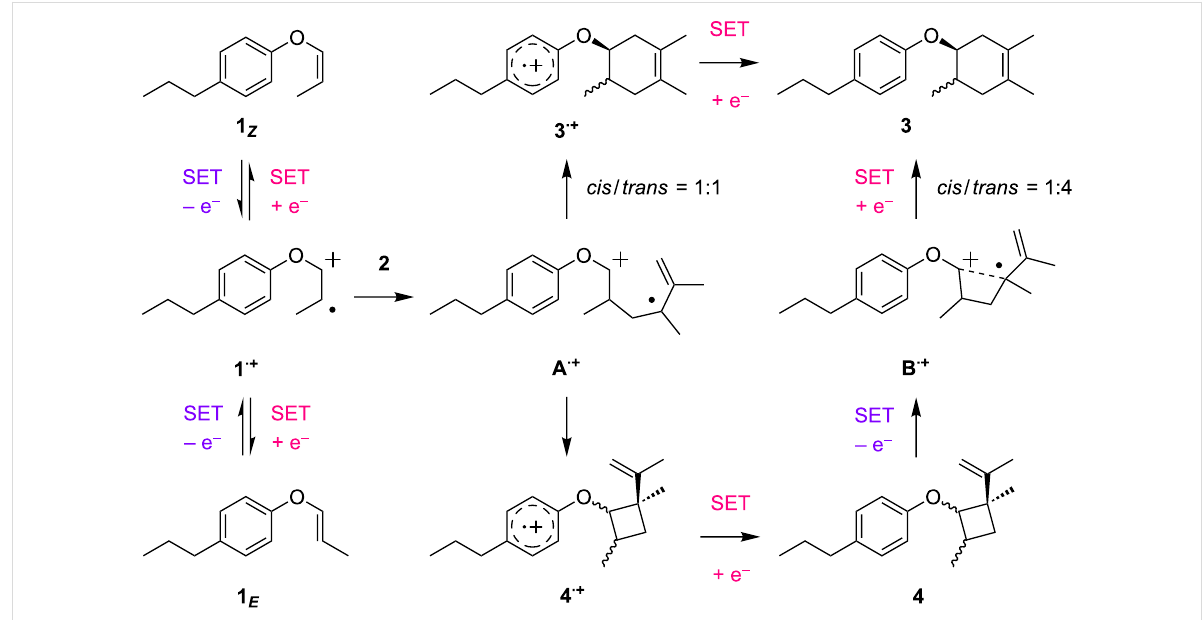
Scheme 7: Proposed mechanism for the radical cation Diels–Alder reaction of aryl vinyl ether 1 .